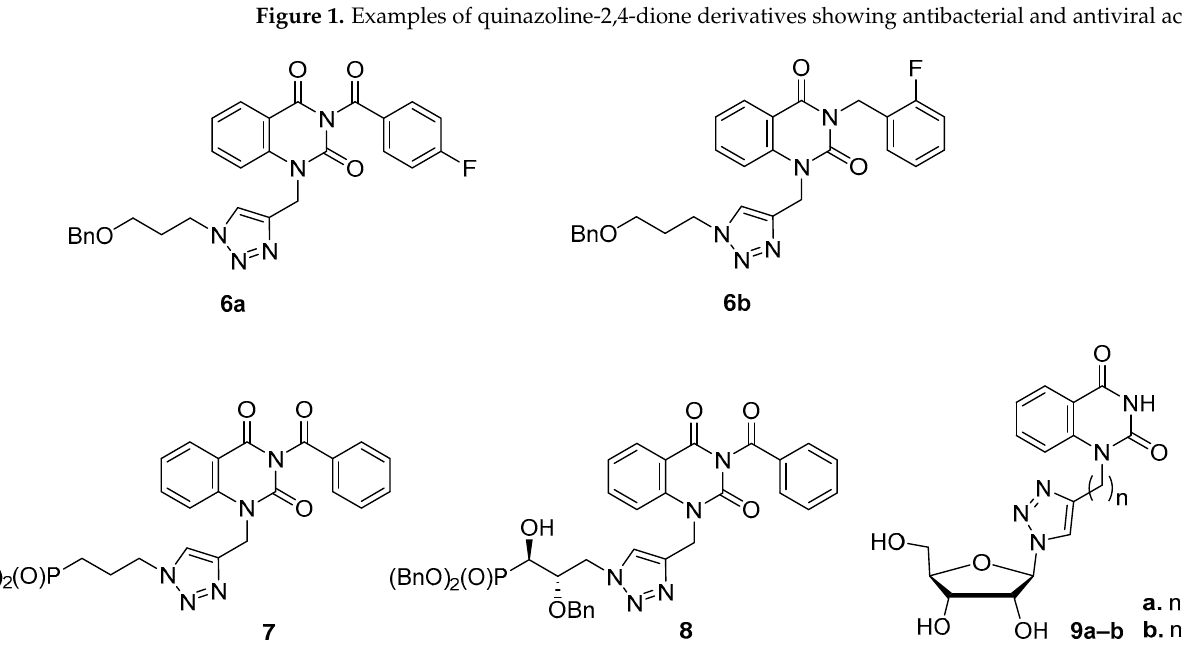
Figure 2. Examples of quinazoline-2,4-dione-containing nucleosides and nucleotides analogues. In the vast majority of natural pyrimidine nucleosides, e.g., uridine and 2 (cid:48) -deoxythymidine and their synthetic analogues, furanose ring or its mimetic is linked to the N1 of a pyrimidine moiety; however, analogues with nucleobase attached to sugar via the N3 atom of pyrimidine have been also obtained. Among them, nucleotide analogues 10 and 11 (Figure 3) show tides [16,17].